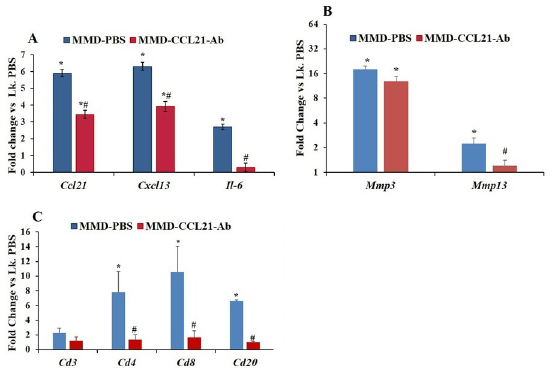
Fig 8. The effect of local blockade of CCL21 function, on inflammation in rat knees, at three days post-surgery. mRNA levels of the major pro-inflammatory cytokine Il-6 and the chemokines Ccl21 and Cxcl13 (A) , Mmp3 and Mmp13 (B) and the markers of four inflammatory cell subsets (C). Right knees (Rk) were MMD-operated and left knees (Lk) were control un-operated from PBS treated rats. Data are expressed as fold change of the expression of each gene in the Rk treated with either 10 μ g CCL21-Ab or PBS vs Lk of rats treated with PBS (Lk. PBS) and are represented as mean ± SE. n = 3–5, � P � 0.05 vs Lk. PBS and #P � 0.05 Rk-CCL21-Ab vs Rk-PBS.